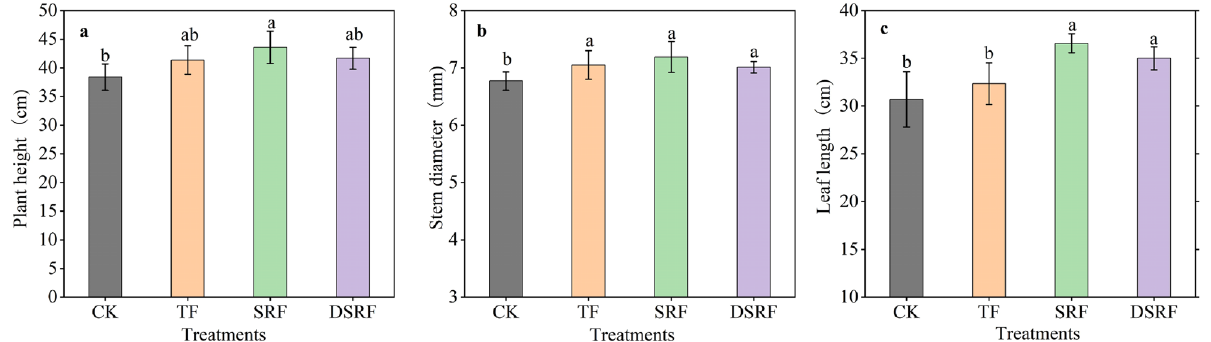
Figure 1. Plant height ( a ), stem diameter ( b ), and leaf length ( c ) of wintering Chinese chives as affected by different fertilizer treatments. Lowercase letters indicate significant differences among different fertilization